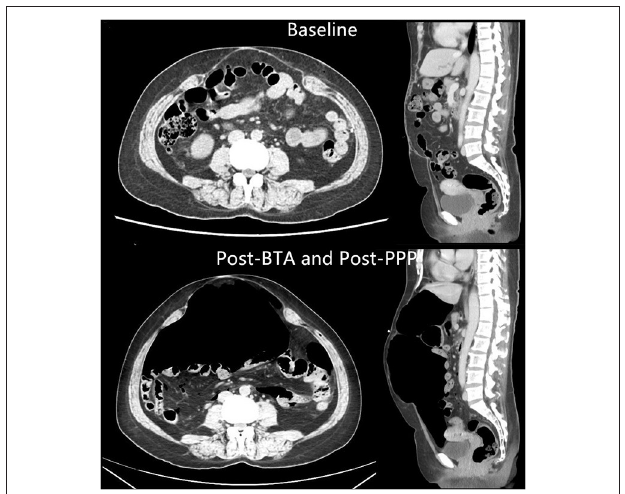
FIGURE 4 | Abdominal CT image comparison of pre-and post-PPP treatments demonstrating spontaneously reinstate the herniated contents (PT-2).